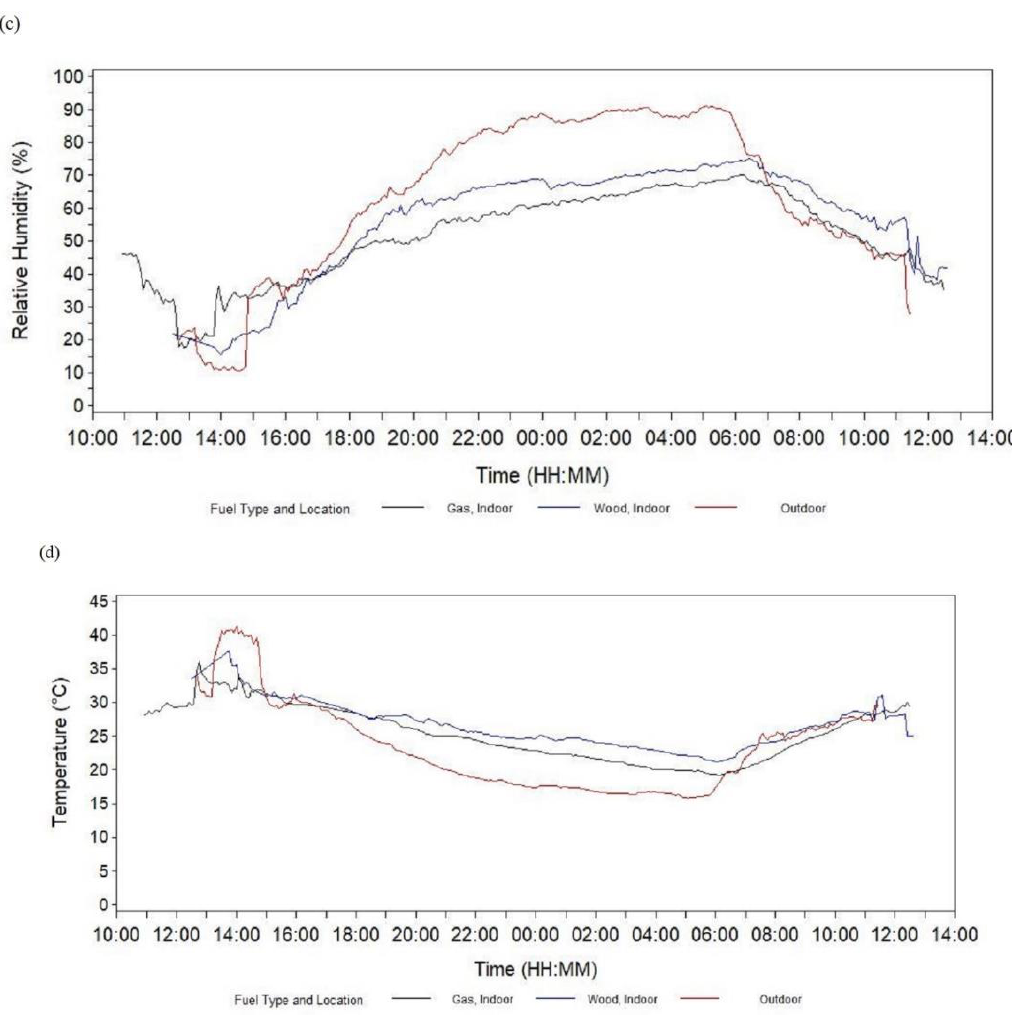
Figure 4. Line graphs of the mean of samples inside or outside a homes over time by fuel type and location at a brick kiln in Bhaktapur, Nepal, May 2019: ( a ) PM 2.5 , ( b ) subset of PM 2.5 (i.e., from 0 to 2,000 μg/m 3 ), ( c ) relative humidity, ( d ) temperature. Abbreviation: PM 2.5 , particulate matter with an aerodynamic diameter less than 2.5 μm. a Nineteen samples were from inside and four samples were